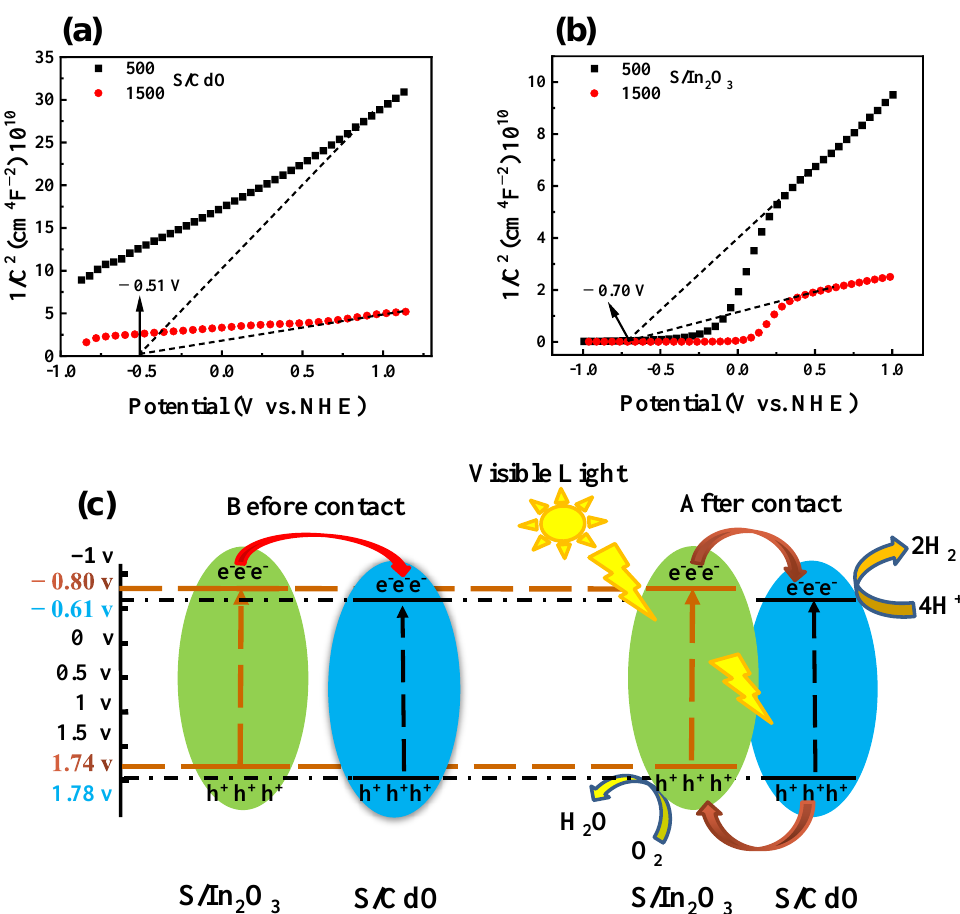
Figure 7. Mott – Schottky plots of ( a ) S/CdO, ( b ) S/In 2 O 3 , ( c ) XPS energy band structure, and possible charge transfer and photocatalytic mechanisms of the as-prepared S/CdO@In 2 O 3 -25 hybrid.